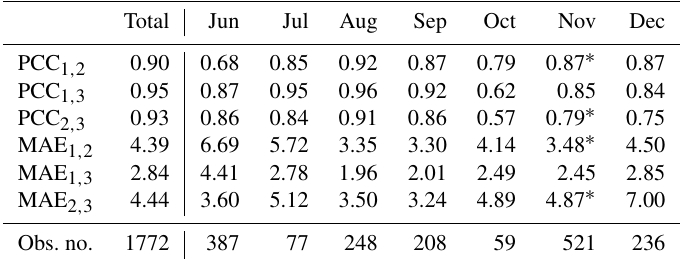
Table 3. Stability of LCS intracorrelation (PCC i,j ) and bias (MAE i,j ), considering the period from 30 May to 14 December 2018. The indices i and j refer to the LCSs between which the comparison is made, e.g. PCC 1 , 2 is the Pearson correlation between the sensors Mrg1 and Mrg2. For each statistical metric, its total, monthly values and the number of hourly observations that are used to perform the calculation are reported. Total Jun Jul Aug Sep